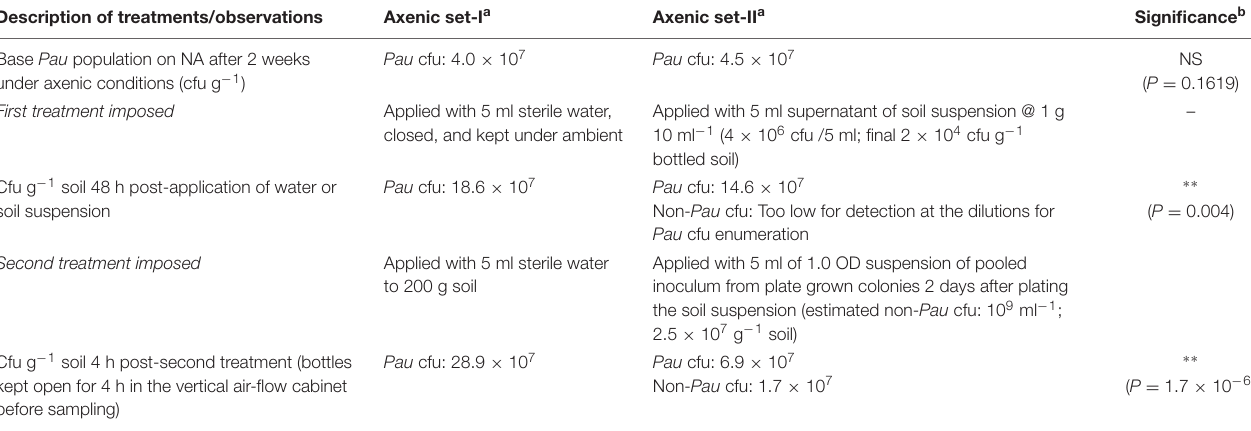
FIGURE 8 | Monitoring of the P. aeruginosa ( Pau ) inoculated soil under axenic conditions (bottles which were maintained under axenic conditions) employing the selective CNA and NA on different dates from the initial inoculation (Bars with same letters are not significantly different at P = 0.05; Values on the bar indicate P -value at 0.05 between the Pau cfu on CNA and NA). TABLE 1 | Effect due to the lateral introduction of soil microbial suspension or soil derived bacterial inoculum on the population of Pseudomonas aeruginosa established in axenic soil for 2 weeks a . Description of treatments/observations Axenic set-I a Axenic set-II a Significance